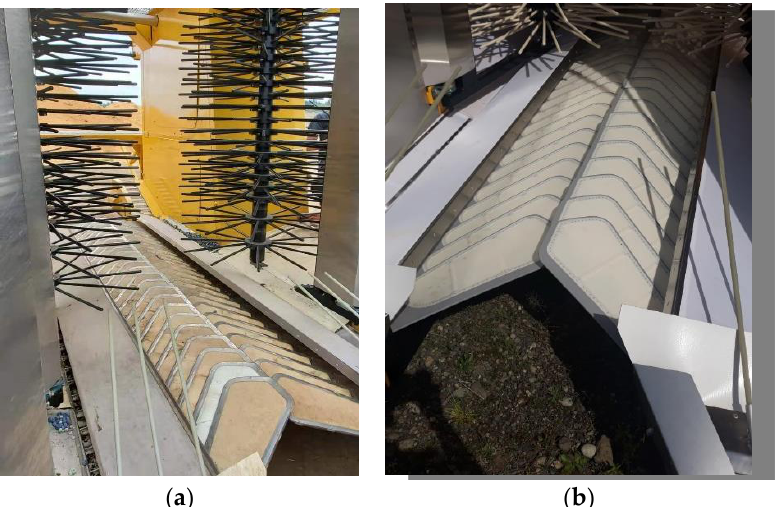
Figure 2. Harvester modifications in the Oxbo 7440: ( a ) experimental, food-grade elastomeric polymer installed in catch plates and intermediary catching surfaces suspended above the conveyor belts in 2019; ( b ) upgraded, patent-pending, food-grade, elastomeric polymer material in 2020 that was injection molded and installed into plastic catch plates.